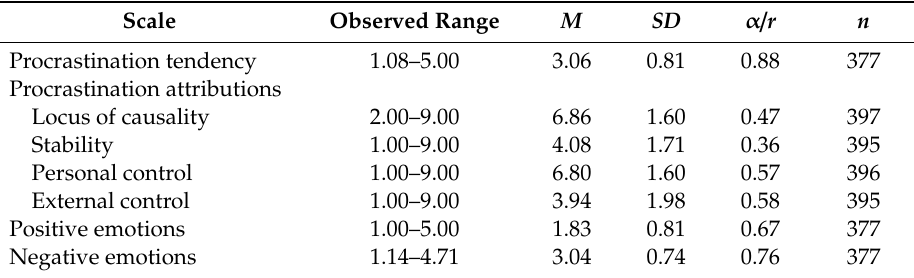
Figure 1. Confirmatory factor analysis (CFA) results for procrastination tendency; all standardized loadings are significant at p < 0.001. * p < 0.05, ** p < 0.001. Model fit indices: χ 2 = 318.395, df = 50. p < 0.001, CFI = 0.829, RMSEA = 0.118. Table 1. Descriptive Statistics for Study